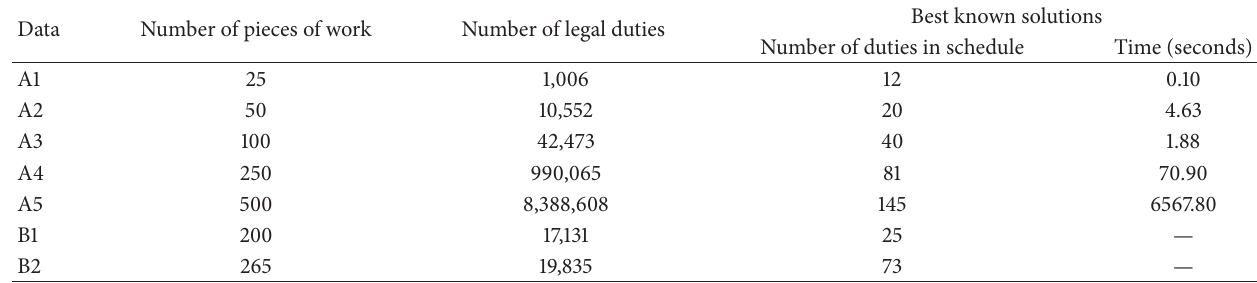
Table 2: Comparative results against the best known schedules.